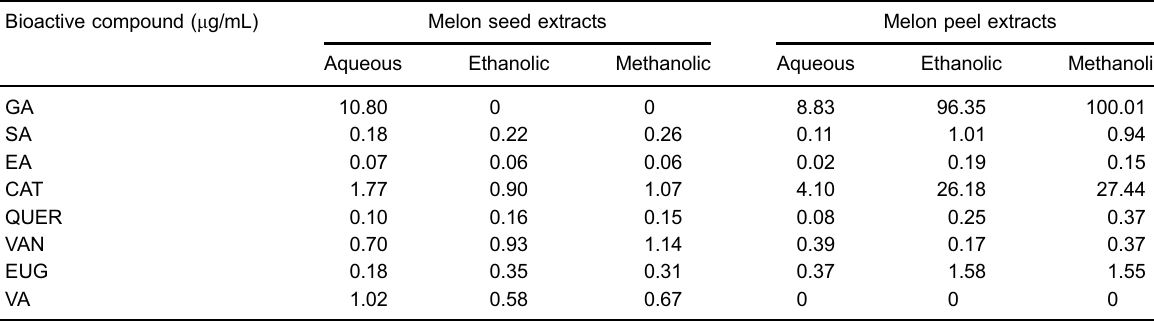
Table 1. Concentrations for the bioactive compounds of melon ( Cucumis melo L. var. reticulatus ) residue extracts. Bioactive compound ( m